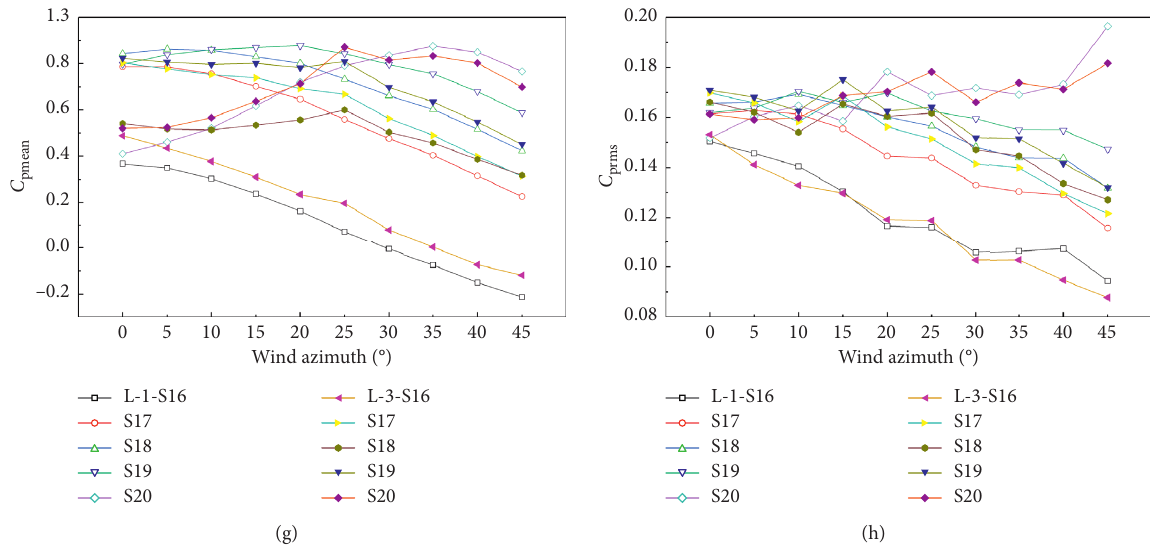
Figure 21: The variation of the mean and fluctuating pressure coefficients of the layer S in the models L-1 and L-3 with the wind direction. (a) Mean pressure coefficients (S1–S5). (b) Fluctuating pressure coefficients (S1–S5). (c) Mean pressure coefficients (S6–S10). (d) Fluctuating pressure coefficients (S6–S10). (e) Mean pressure coefficients (S11–S15). (f) Fluctuating pressure coefficients (S11–S15). (g) Mean